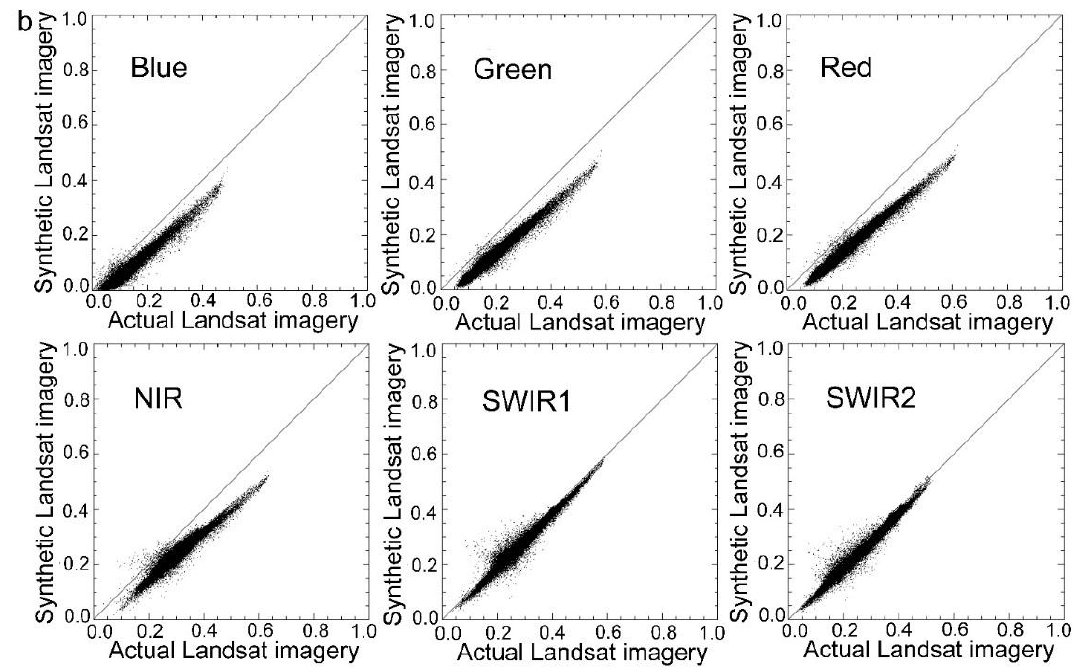
Figure 5. Scatter plots between actual and synthetic images of Landsat in ( a ) Bole and ( b ) Luntai by using the spatial and temporal data fusion approach